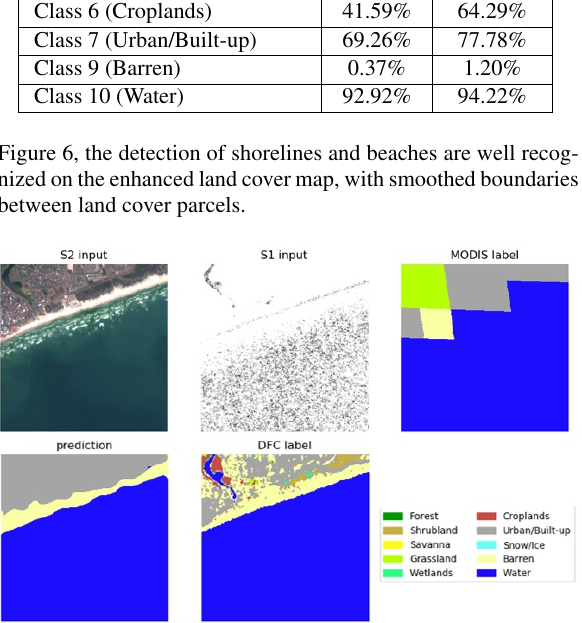
Figure 6: Detection of shoreline and beach